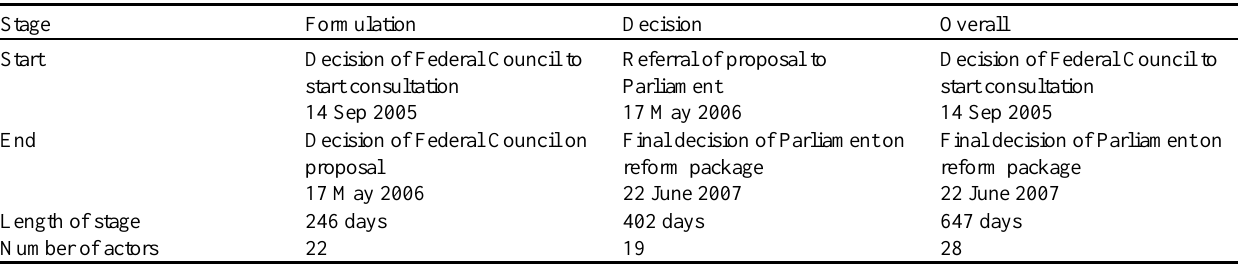
Table 1 . Policy process delimitation and network